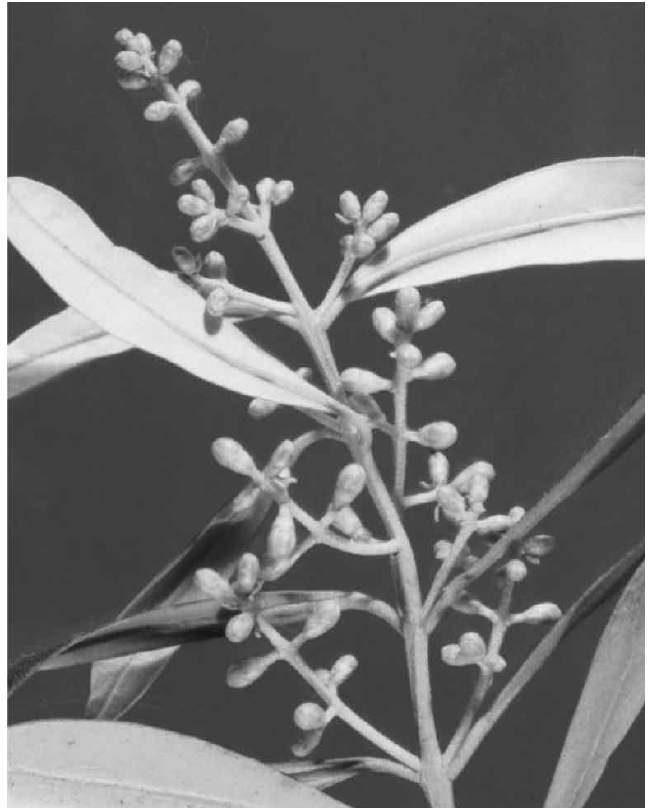
Fig. 2 - Terminal bud transformed in floral grape in cv. Koroneiki (Pho- to E. Marone).